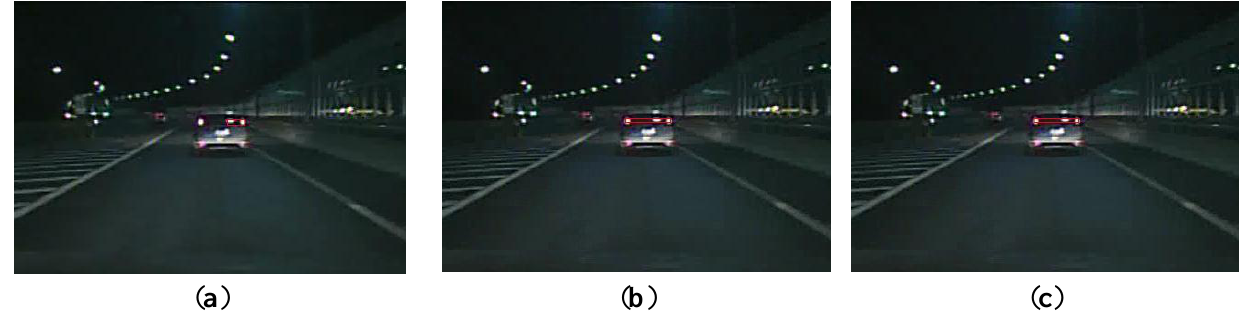
Figure 10. Comparison of vehicle detection results (case 1): ( a ) Result using the global rule-based algorithm; ( b ) Result using Kalman tracking-based global algorithm; ( c ) Result using the proposed algorithm.